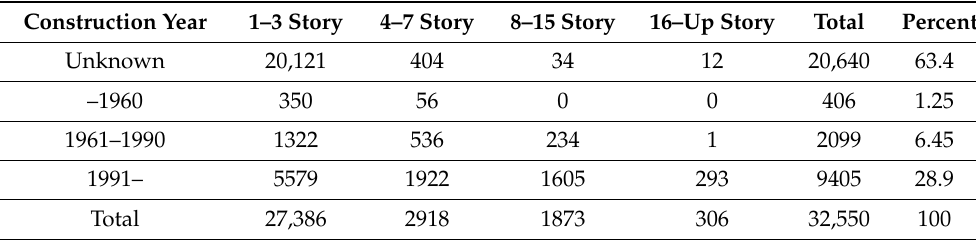
Table 3. The number of buildings with construction year and a number of stories in existing inven- tory